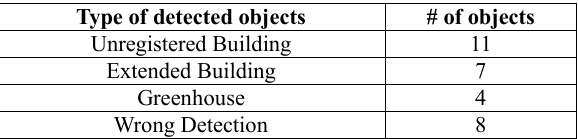
Table 2. The detection result of our system